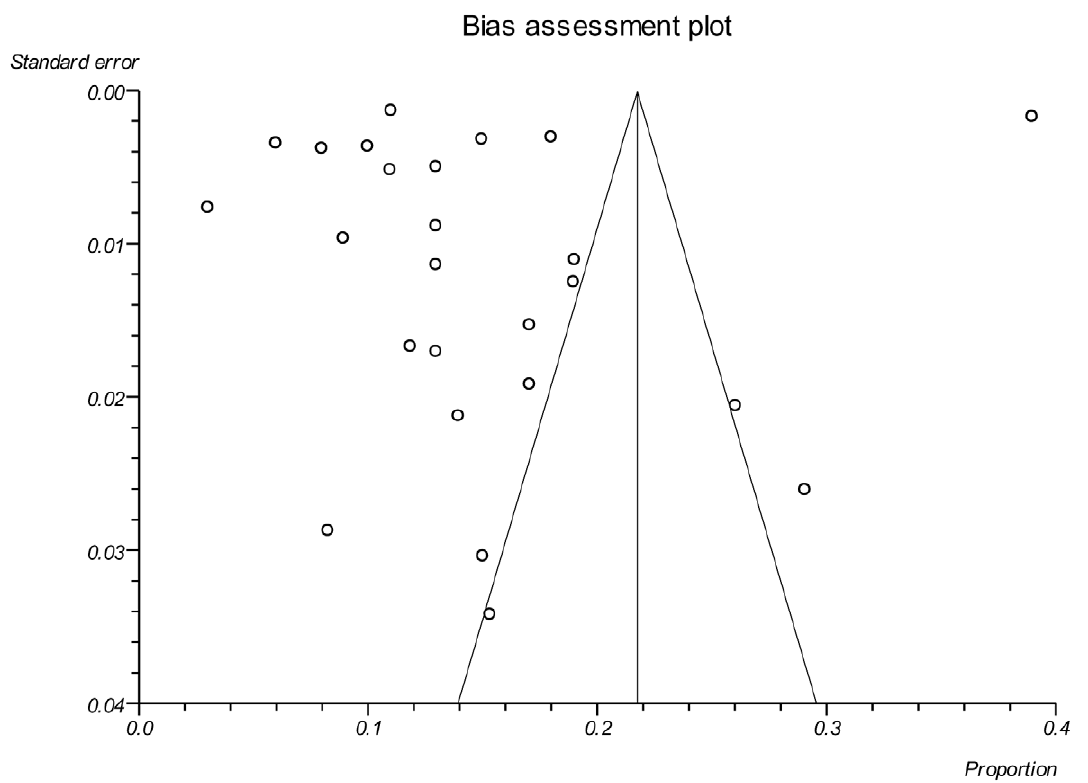
Figure 4. Funnel plot. The funnel plot assesses the hypothesis that the relationship between probability of death and study size, measured by standard error, is independent. This was tested using a Kendall’s tau, which was estimated to be 0.4 with p-value=0.0046, suggesting there is evidence of asymmetry. Although the presence of publication bias is a common explanation to an asymmetric funnel plot, data presented here are observational data without any intervention so the funnel plot asymmetry could also be due to heterogeneity in the data